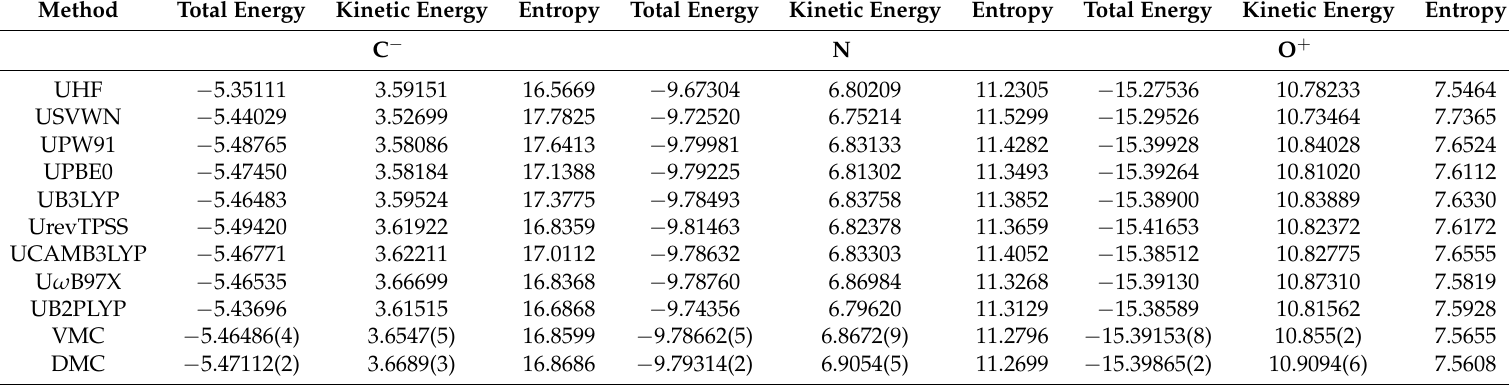
Table 2. Total energy, kinetic energy and Shannon entropy for some atomic systems of the N-like series calculated at different level of computation. Data are in